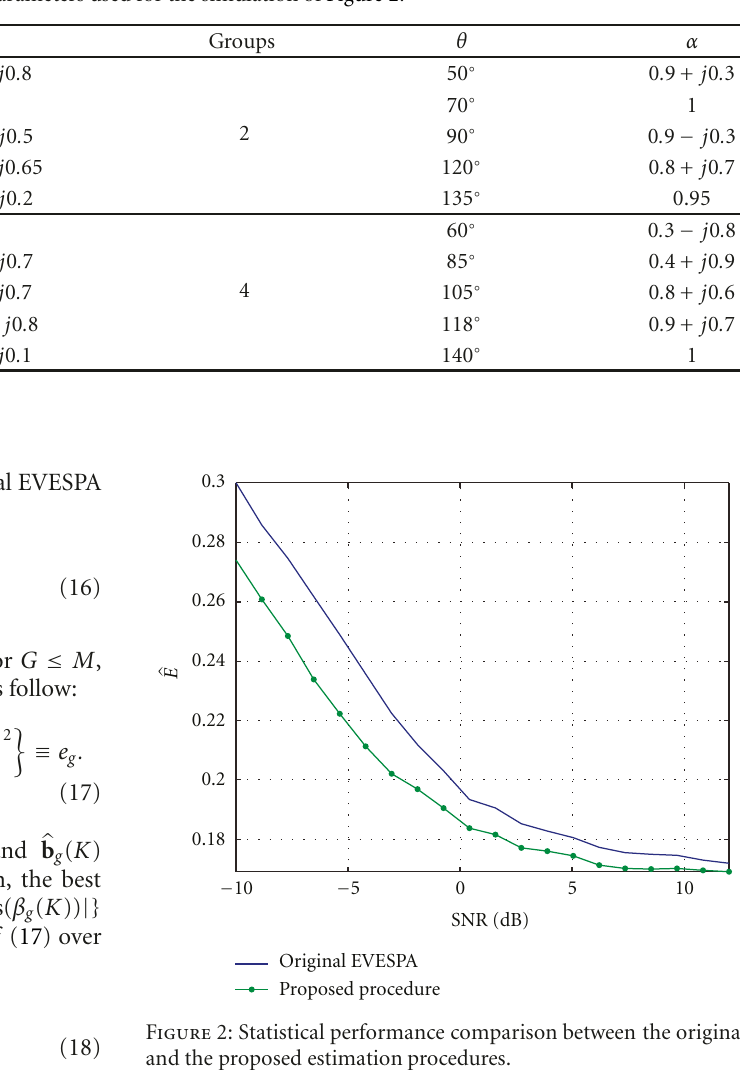
Table 2: Signal parameters used for the simulation of Figure 2.